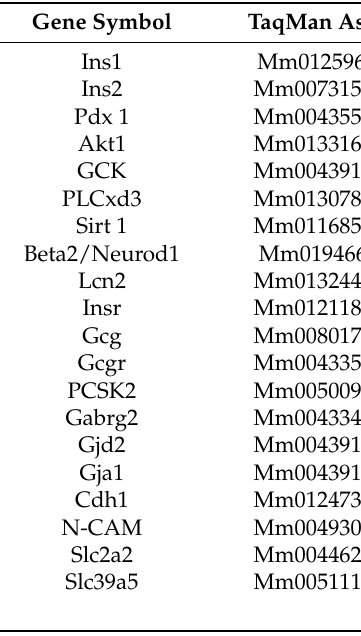
Table 2. List of genes examined for expression from mono- or co-cultured MIN-6 and α -TC1-6 cells. Gene Symbol TaqMan Assay